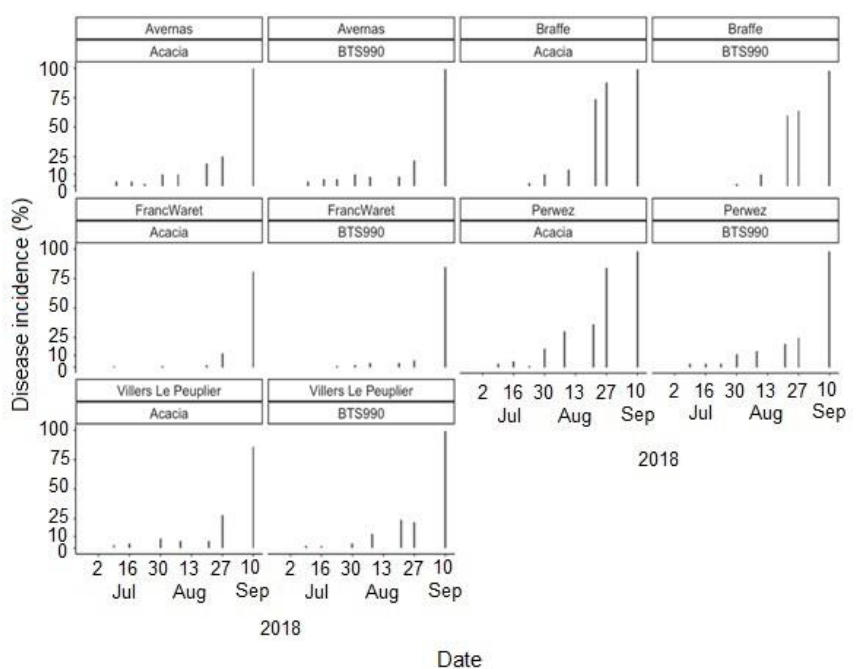
Figure 4. Observed incidence of Cercospora leaf spot at Avernas, Brafffe, Franc-Waret, Perwez, and Villers-le-Peuplier, Belgium, during the 2018 cropping season. Two different cultivars were monitored at each site.